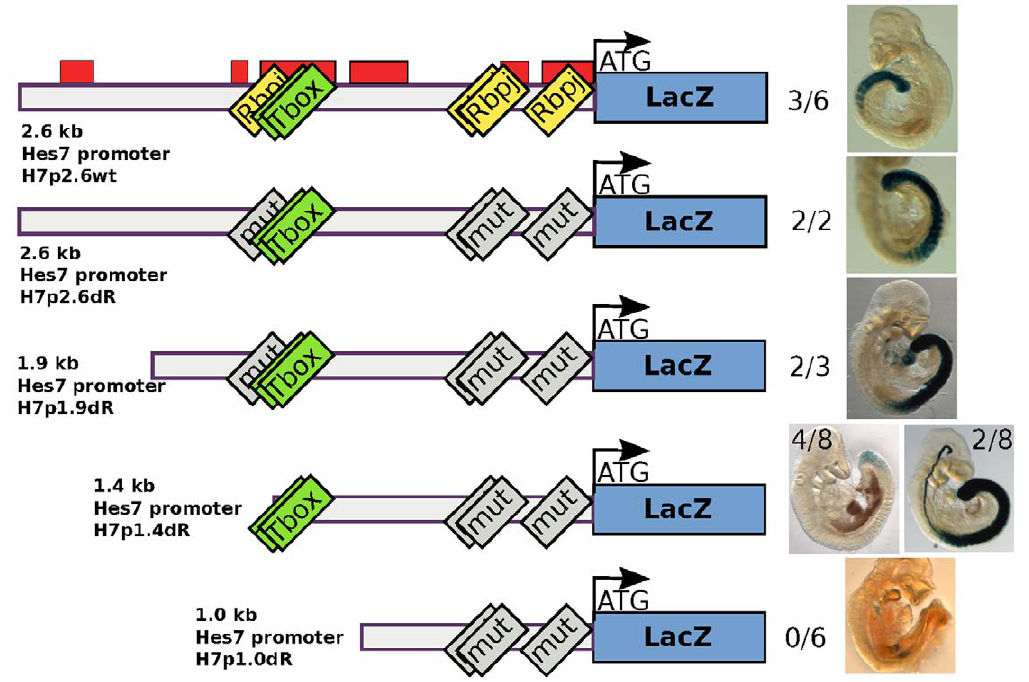
Figure 1. Hes7 promoter analysis with lacZ reporter transgenic embryos. The left side is a scheme of the Hes7 promoter constructs. From top to bottom: H7p2.6wt, H7p2.6dR, H7p1.9dR, H7p1.4dR and H7p1.0dR. The promoter size relative to the transcription start is shown. The red boxes show conserved sequences according to the Vista browser [33]. The yellow and green boxes show Rbpj and T-box binding sites, respectively, while the gray boxes stand for mutated sites. The two numbers show the number of X-gal positive embryos and transgene positive embryos, respectively.